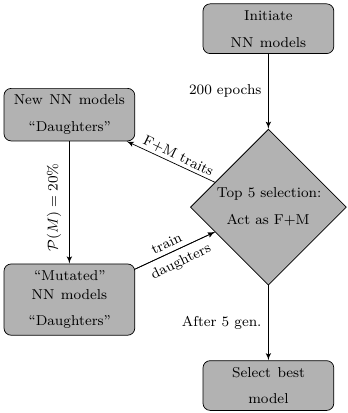
Figure 6. Diagram representative of the iterations involved in the evolutive algorithm as used in this